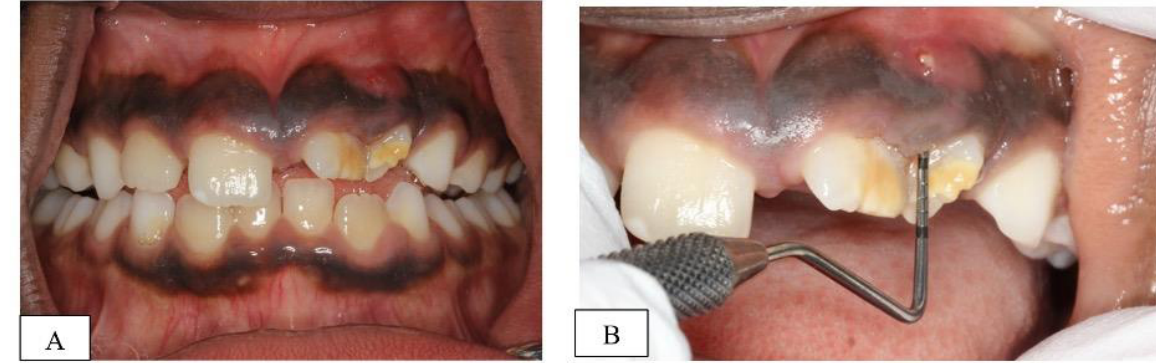
Figure 1. ( A ): frontal clinical view of patient’s dentition at initial assessment, ( B ): closer view of the hypoplastic teeth (21&22) showing the labial sinus tract and the increased probing depth (9 mm). Using the horizontal parallax technique, the “extra tooth” appeared to be in a labial position (Figure 2). In the same radiographs, a gutta-percha point was used to trace the origin of the sinus tract. The radiographic evaluation revealed the abscess was related to the “extra tooth” (Figure 2).